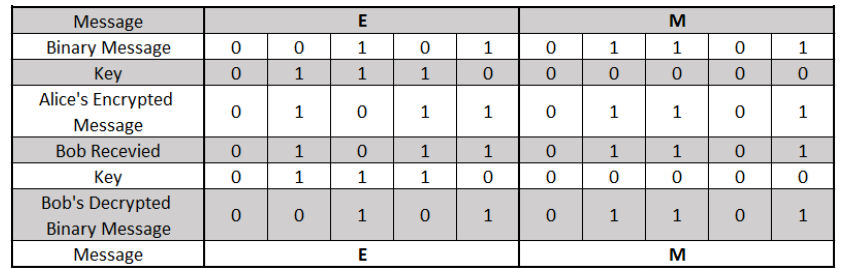
Figure 7. An 18 bit transmitted message between Alice and Bob.